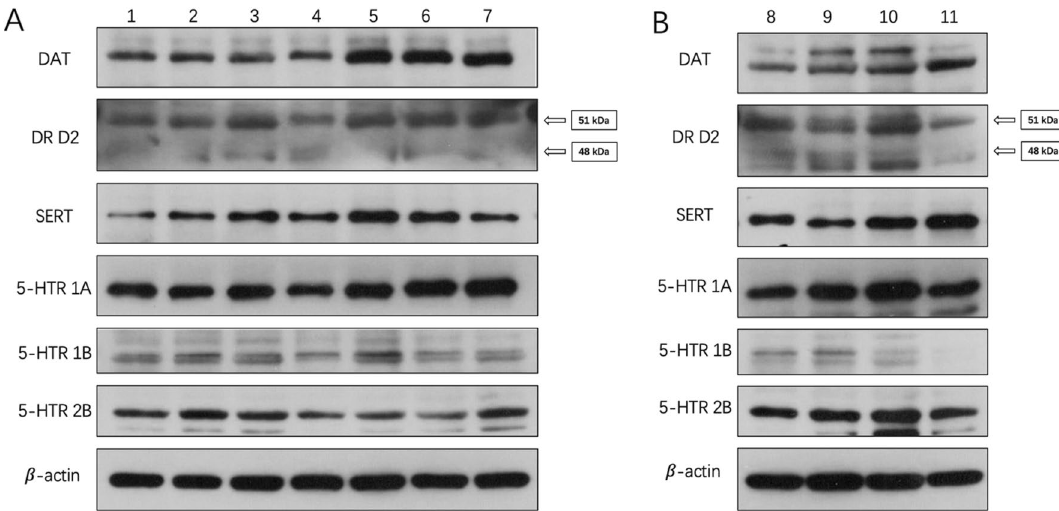
Figure 6. Effects of sulpiride and clozapine on the translation levels of functional proteins involved in DAergic and 5-HTergic systems in zebrafish diencephalon. Note: 1. Control, 2. 20 ng/L sulpiride group, 3. 50 ng/L sulpiride group, 4. 100 ng/L sulpiride group, 5. 20 ng/L clozapine group, 6. 50 ng/L clozapine group, 7. 100 ng/L clozapine group, 8. Control, 9. 20 ng/L sulpiride and clozapine mixture, 10. 50 ng/L sulpiride and clozapine mixture, 11. 100 ng/L sulpiride and clozapine mixture. The grouping of blots was first cropped from different gels and then transferred onto PVDF membranes (1:1) prior to hybridisation with